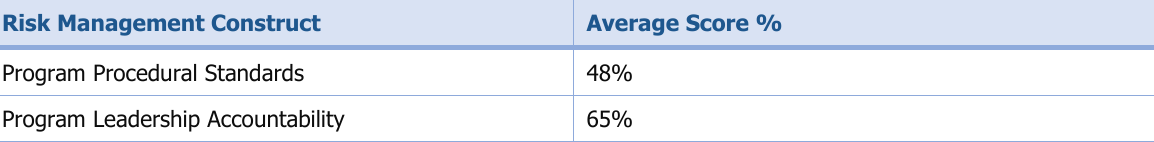
Table 5. Average Score for Program Procedural Standards and Program Leadership